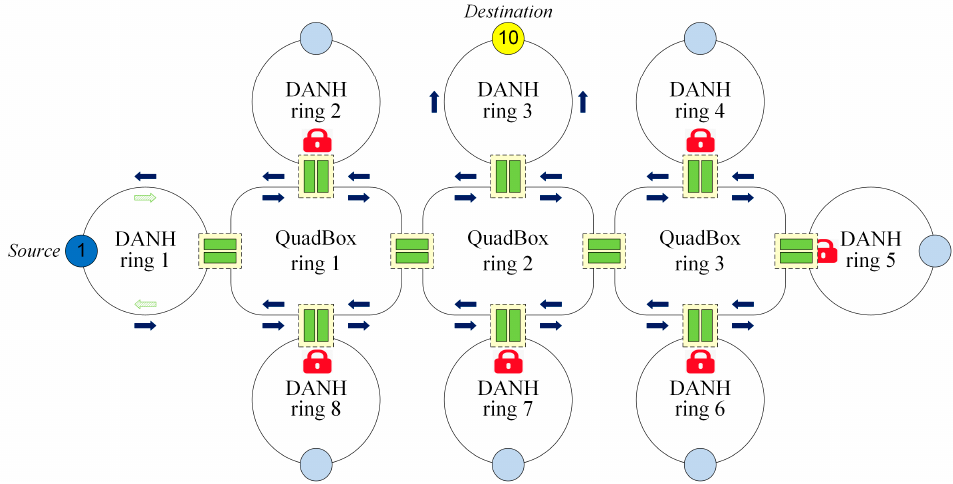
Figure 4. Forwarding a unicast frame using the port locking (PL) technique.